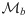
Global RoCoF disturbance magnitude Mb as a function of squared Fiedler components u2b2 for power losses on 20 different bus #b for (a) the European and (b) the ERCOT grid.Labeled symbols correspond to locations indicated in Fig 8. The plots look similar when Mb is plotted against the squared component u3b2 of the second slowest mode of the Laplacian.